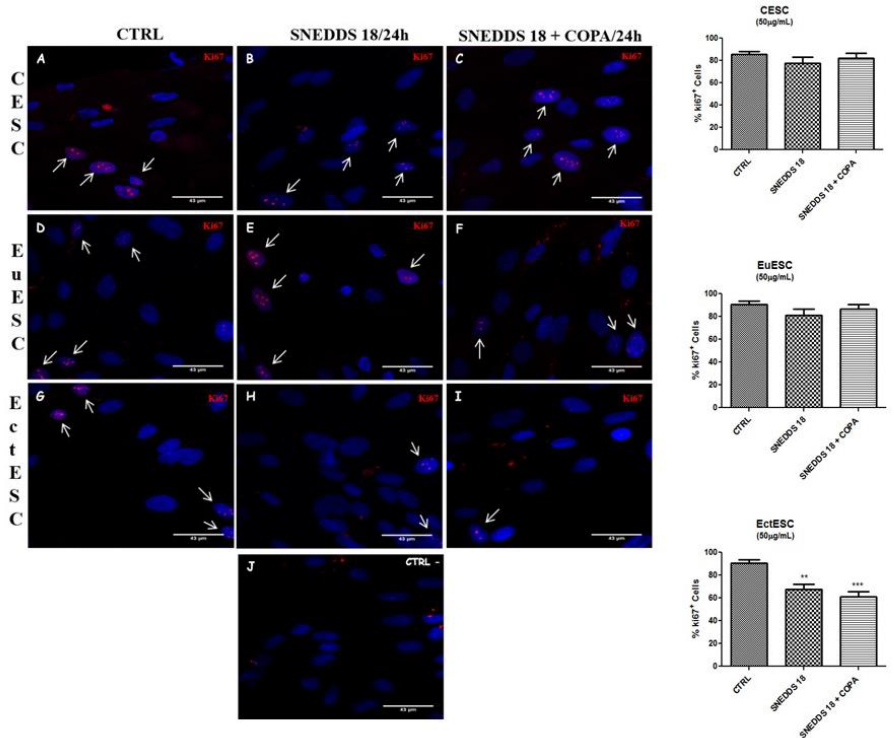
Figure 3. Immunostaining of Ki-67-positive cells (left photos). CESC ( A – C ), EuESC ( D – F ), and EctESC ( G – I ) were incubated with Ki-67 and treated or left untreated with SNEDDS-18 or SNEDDS- 18/COPA (50 µg/mL) for 24 h. In ( J ), the negative reaction is shown. In red is Ki-67 labelling, and in blue is DAPI (nuclear marker) labelling. Representative images of three independent experiments performed in triplicate. Scale bar = 43 µ m. Percentage of Ki-67-positive cells (right graphs). Results are expressed as mean ± SD. ** p < 0.01; *** p < 0.001 when comparing SNEDDS-18 or SNEDDS- 18/COPA with vehicle group. CESC: Endometrial stromal cells obtained from topic endometrium of patients without endometriosis; EuESC: Endometrial stromal cells obtained from topic endometrium of endometriosis patients; EctESC: Endometrial stromal cells obtained from ectopic endometrium of endometriosis patients (endometriotic lesions); SNEDDS-18: Nanoemulsion containing Babassu oil; SNEDDS-18/COPA: nanoemulsion containing Babassu oil and Copaiba oil resin.